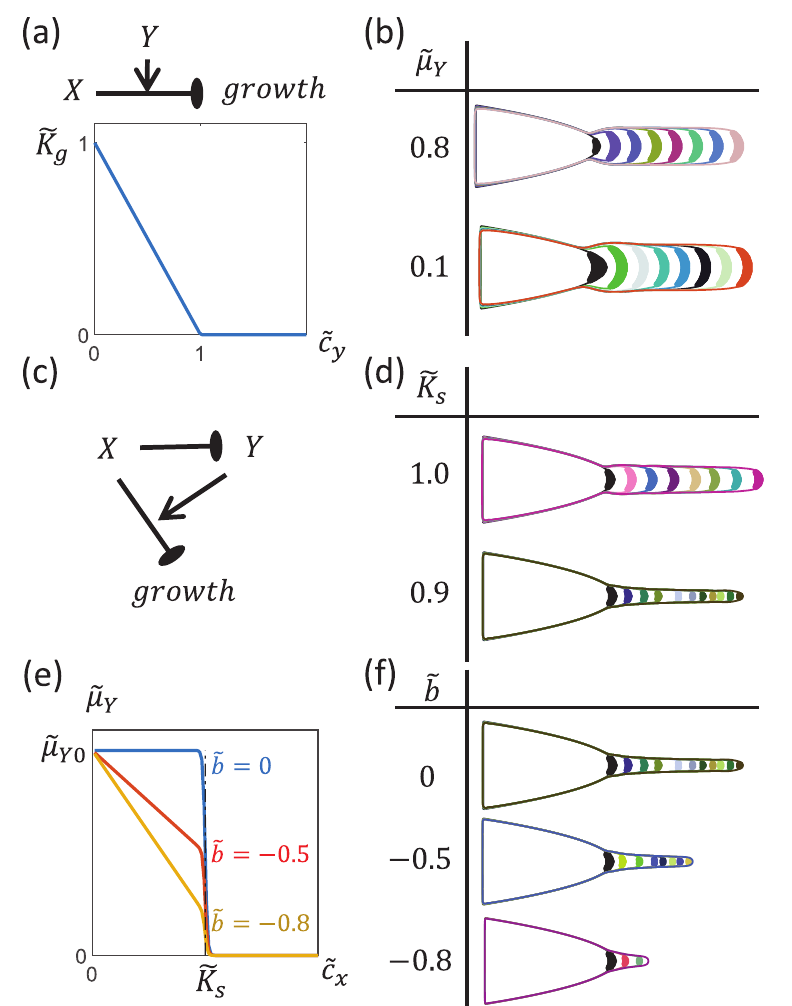
Fig 5. Dynamics of cluster when cells secrete a growth threshold regulator in addition to a growth inhibitor. (a) Y reduces the growth threshold of X . Here, we have chosen the rescaled growth threshold ~ K with the rescaled concentration ~ c ¼ ac . (Eq 9) (b) The cluster grows a rod-like structure when all cells secrete Y at a Y Y D 1 constant effective rate ~ m ¼ a m Y . (c) We consider the scenario where X inhibits the production of Y such that only a Y g 1 D 2 region at the tip of the tissue can secrete Y . (d) For the scenario described in (c), it is possible for the protrusion to become narrower over time if the secretion threshold is less than the growth threshold ~ K bottom: ~ m ¼ 15 ). (e) We also allow the maximum secretion rate of Y to decrease linearly with c Y ~ K ¼ 0 : 9 , a stronger regulation of μ (more negative ~ b ) produces sharper cone-like structures (top: ~ m Y , max s middle: ~